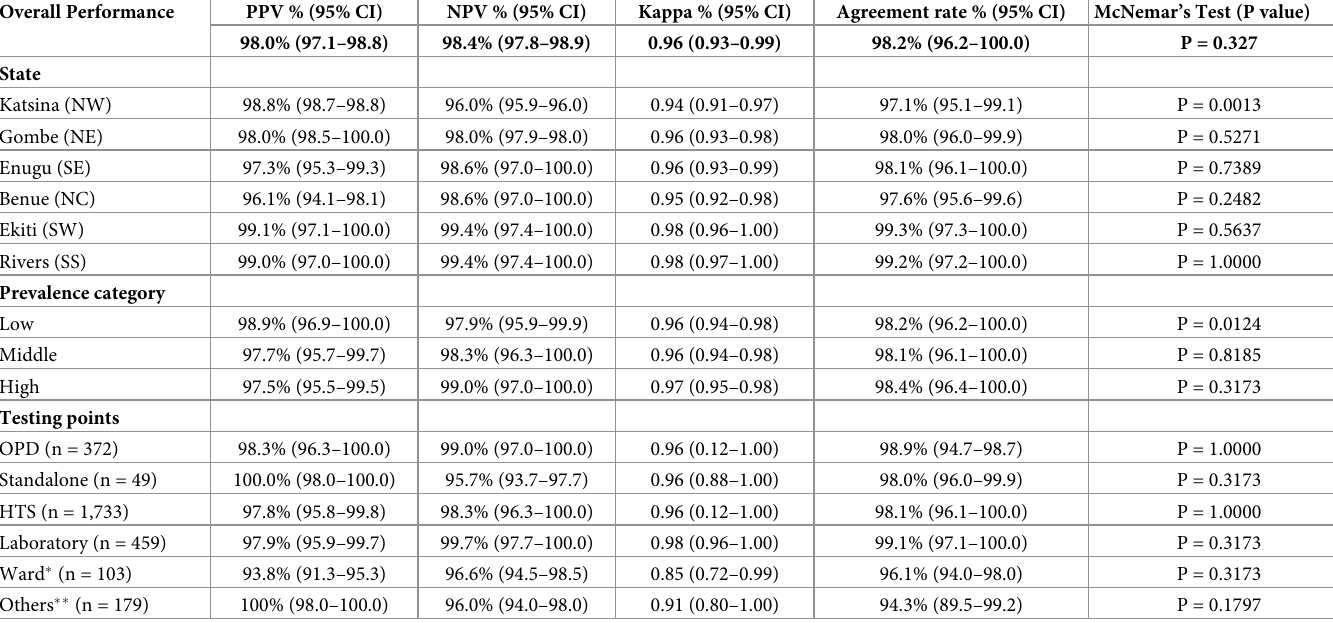
Table 4. Performance comparison of the national serial HIV rapid testing algorithm between the field and NRL across states, prevalence categories, and testing points using NRL re-testing results as a reference. Overall Performance